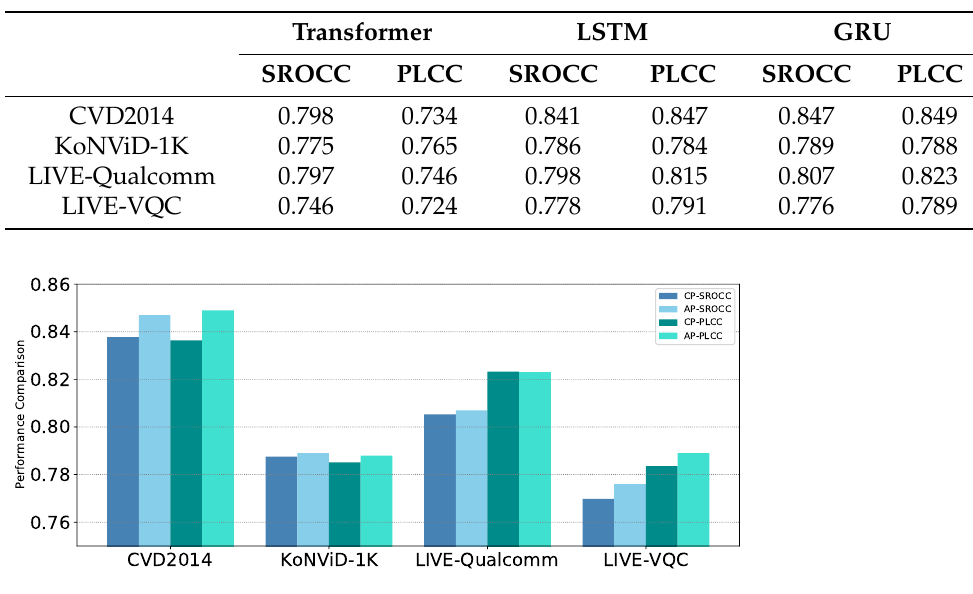
Figure 11. Performance of CP vs. AP on four benchmark databases. Abbreviations CP for constant parameters and AP for adaptive parameters (In CP, α is set to be